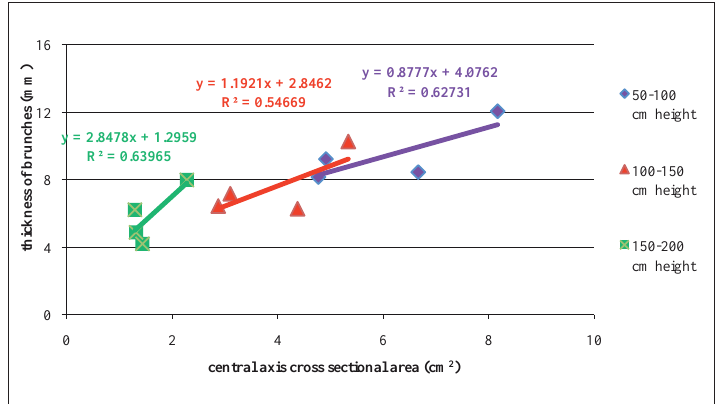
Figure 6: Relationship between the tapering dynamics of the central leader and the thickness of the main branches in super spindle canopy (Nyírbátor,